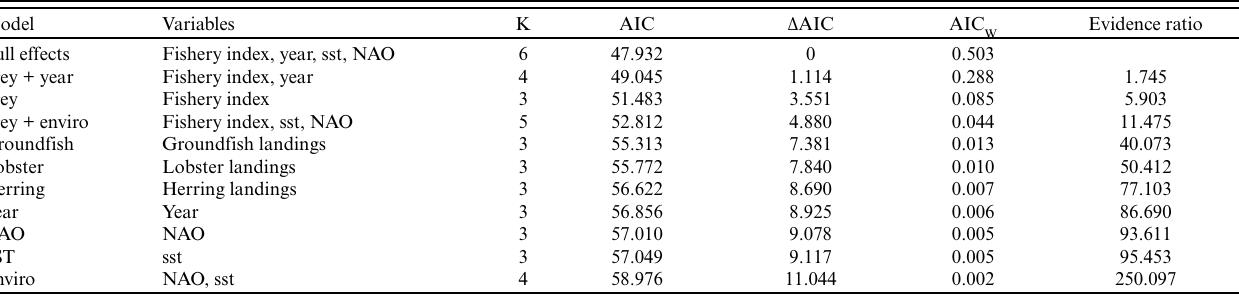
Table 1 . Candidate models and AIC scores testing the effects of prey availability and environmental factors on Herring Gull ( Larus argentatus ) egg volume on Kent Island from 1988–2014. Lobster = total lobster landings in LFA 35-38, herring = Atlantic Herring landings in 4WX, Groundfish = total groundfish landings in Atlantic Canada. Fishery Index = index encompassing lobster, herring, and groundfish landing data, sea surface temperature (SST) = average sea surface temperature in May, North Atlantic Oscillation (NAO) = Winter (December–February) North Atlantic Oscillation Index, K = parameter count, AIC = Akaike Information Criterion, AIC = Akaike Information Criterion weights.